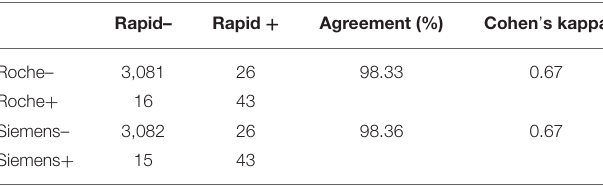
TABLE 3 | Agreement between the rapid test and the Roche and Siemens